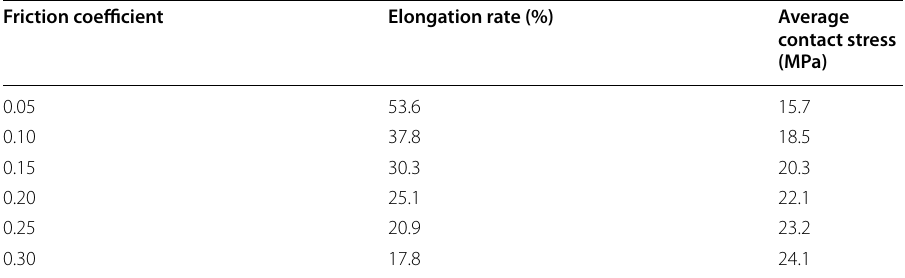
Table 4 The elongation rate and average contact stress of rubber cylinder with different friction coefficient Friction coefficient Elongation rate (%) Average